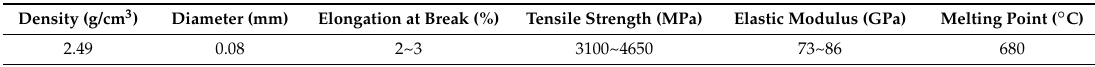
Table 2. The basic physical and mechanical parameters of the fiber glass.